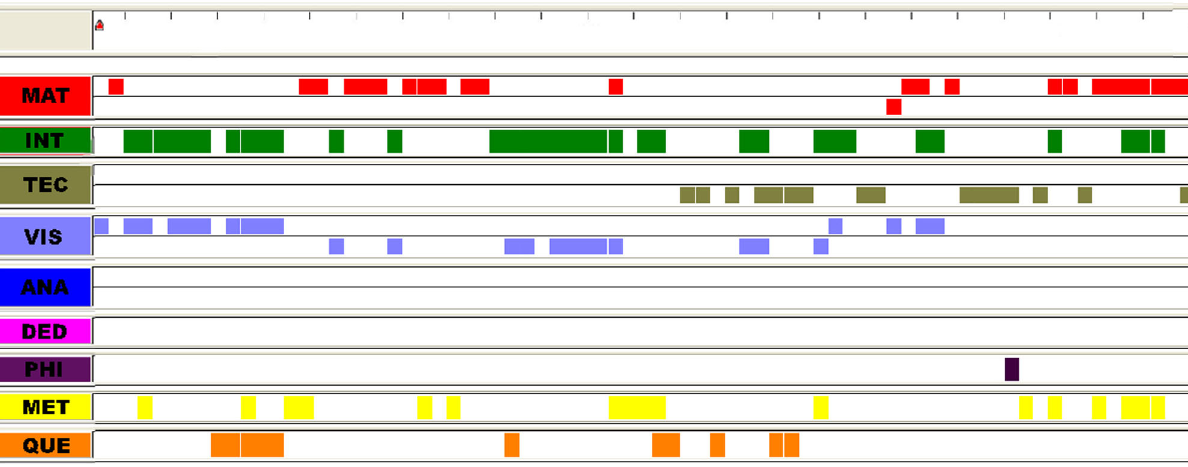
FIG. 3. Timeline of the charged plate problem